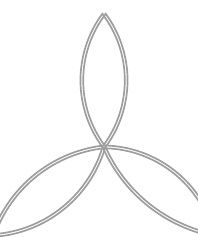
Figure 8 (b). Clover diagram in Higgs regular- ization after additional integration. It produces a massive tadpole with squared propagator (in- dicated with the dot) times two massive